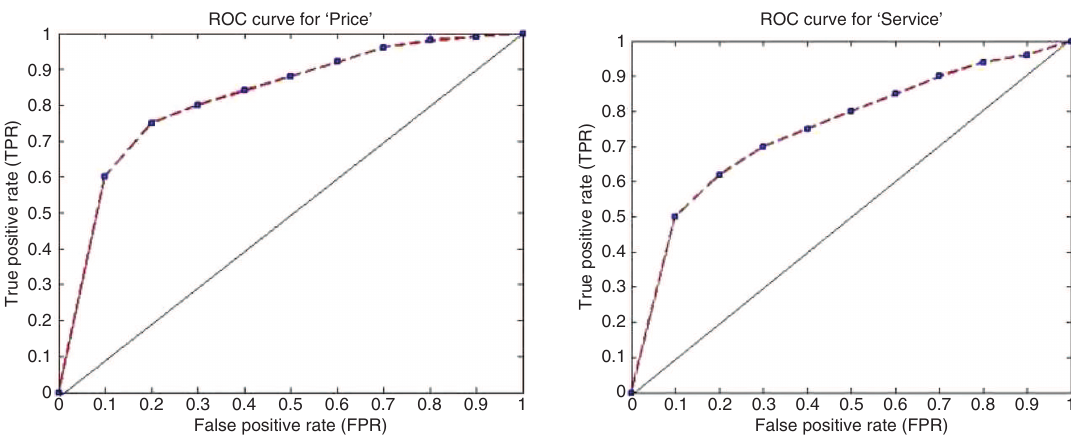
Figure 4: ROC Plots for “Price” and “Service”.